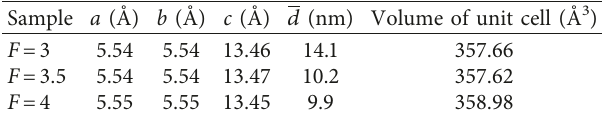
3.5, 4, and Table 1: The lattice parameters and crystallite size of the LaMnO samples with different ratios of glycine/nitrate molar ( F and 4).